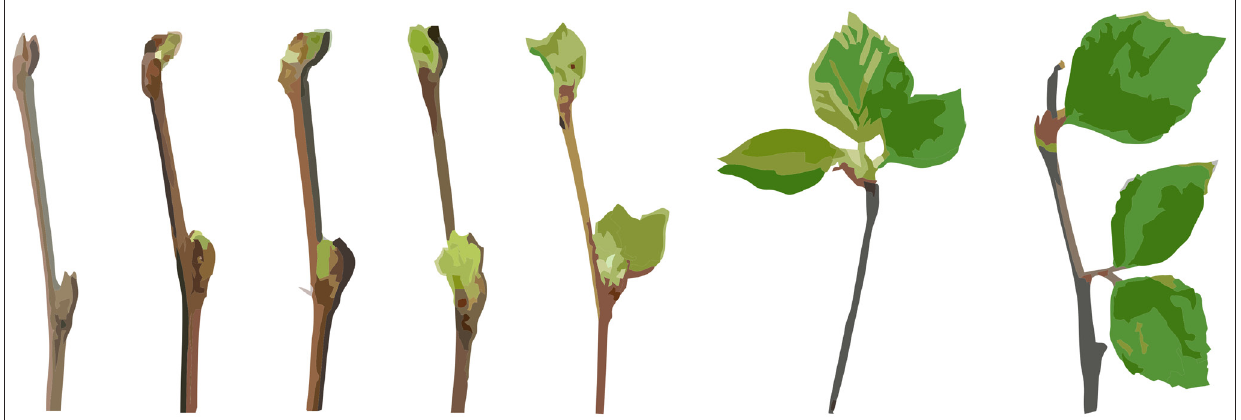
Figure 3 Key to the stages of Betula sp. (birch) spring phenology. These seven images show the progression of canopy flushing (bud burst and leaf unfolding). Redrawn using Kubin et al. (2007) as a